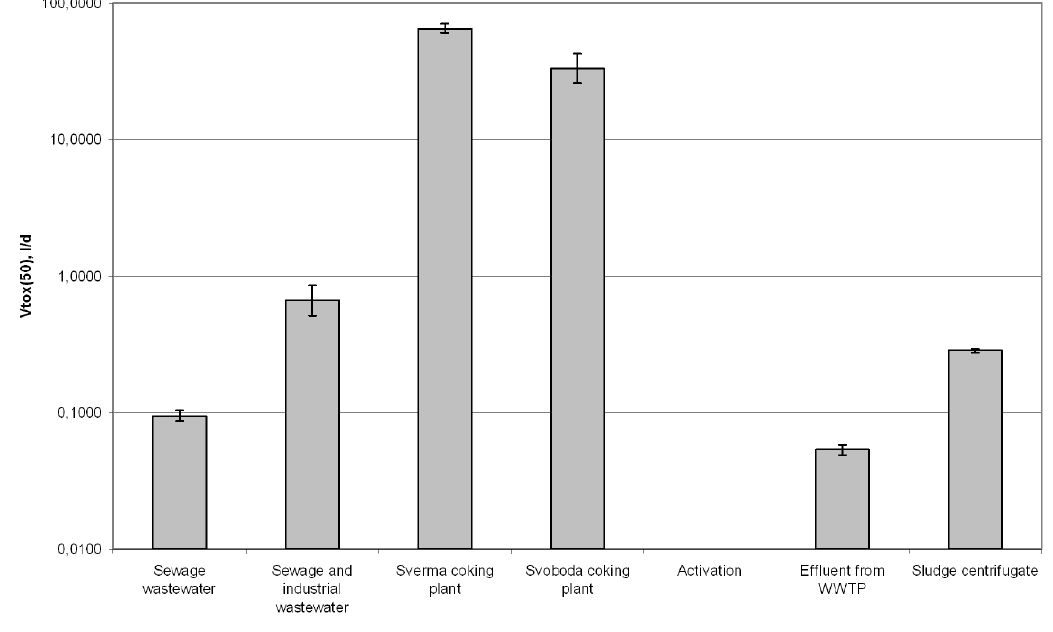
Fig. 3 Toxicity of SPMD samples from monitored pro› les in WWTP to Desmodesmus subspi-